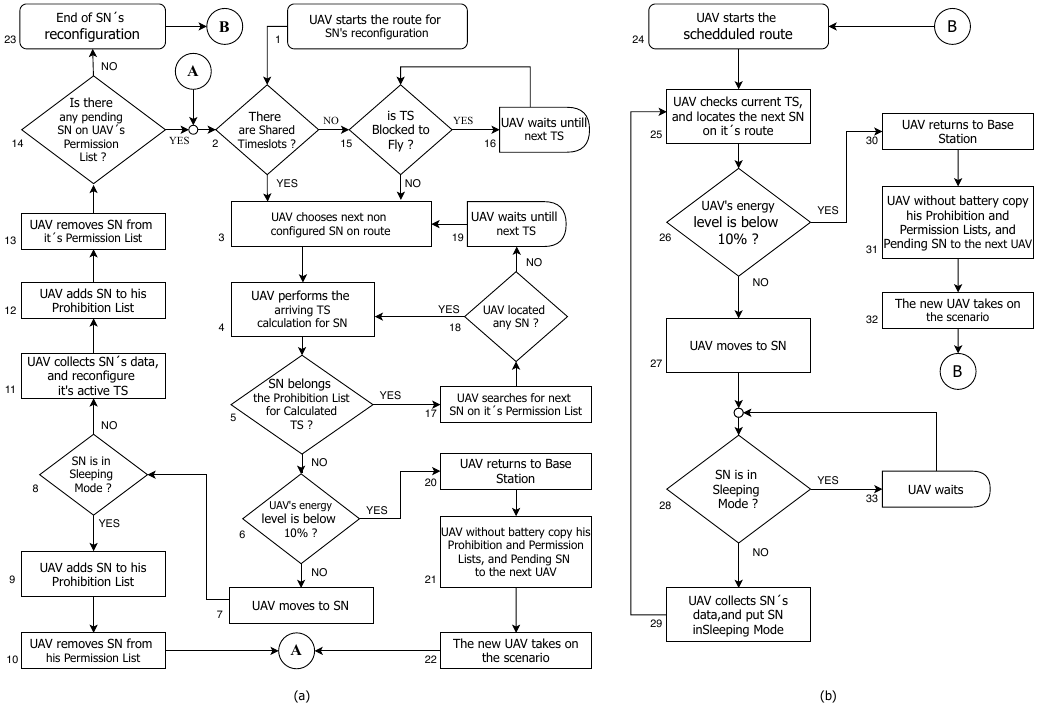
Figure 11. ( a ) strategy adopted by UAV for SNs reconfiguration phase; ( b ) strategy adopted by UAV after the SN reconfiguration